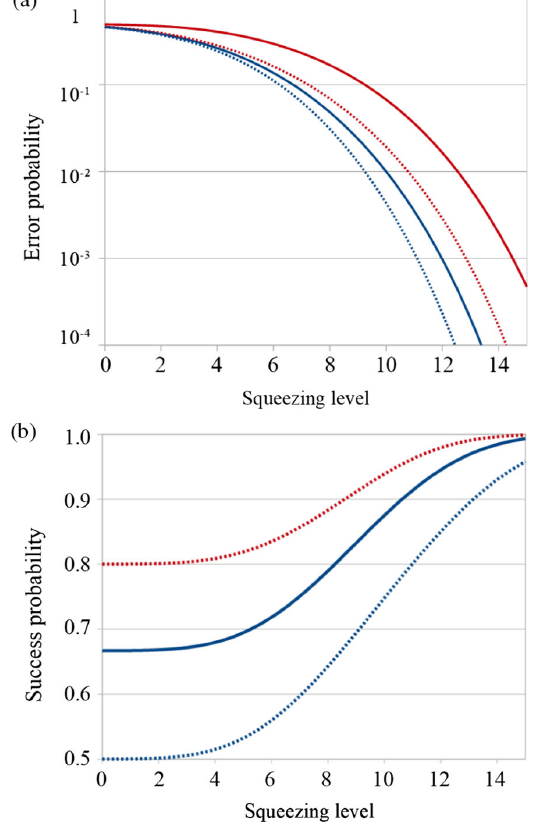
FIG. 5. The error probabilities of the postselected measurement E and the success probabilities of the postselected measure- post on the qubit of variance 3 σ 2 . (a) The error probabilities ment P suc with the method using only the CZ gate, and our method using the postselected measurement for the upper limit v ffiffiffi p ¼ π = 10 (red dashed line), v solid line), v ffiffiffi p up ¼ π = 4 (blue dashed line), respectively. solid line), and v up (b) The success probability for our method. The squeezing level is equal to − 10 log 10 6 σ 2